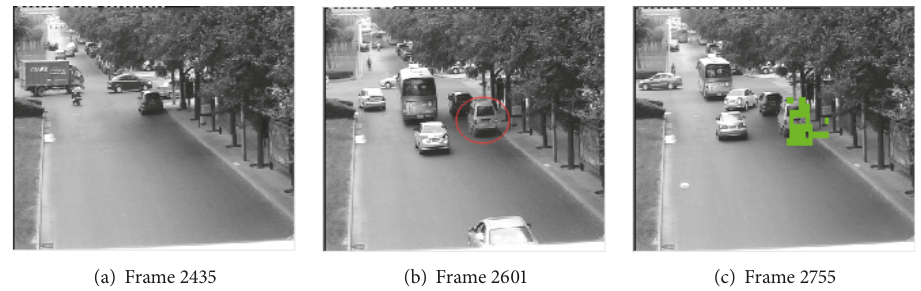
Figure 9: Xi’an South Second Ring Busway parking detection results.